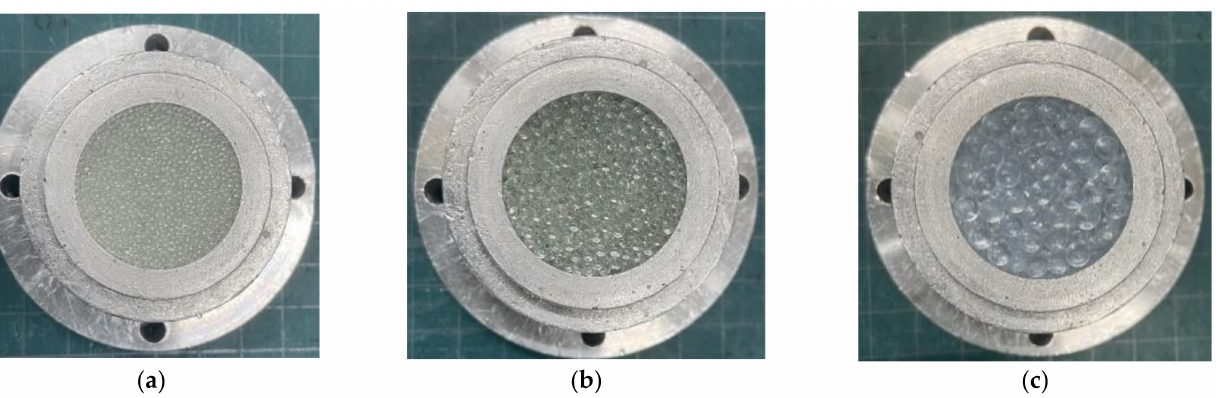
Figure 1. Test samples of random packing granules: ( a ) d = 1 mm; ( b ) d = 2 mm; ( c ) d = 4 mm. A sample holder tube by aluminum alloy with an inner diameter of 29 mm was filled with glass